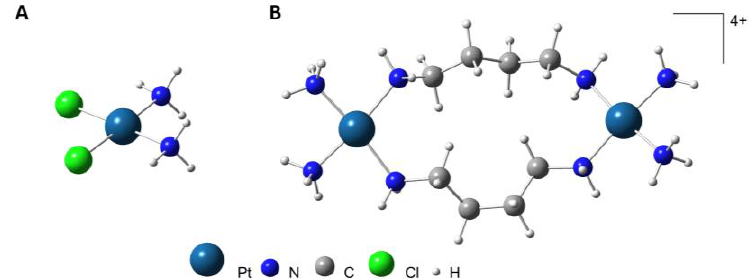
Figure 1. Schematic representation of the complexes cisplatin ( A ) and [Pt 2 Put 2 (NH 3 ) 4 ] 4+ ( B ).